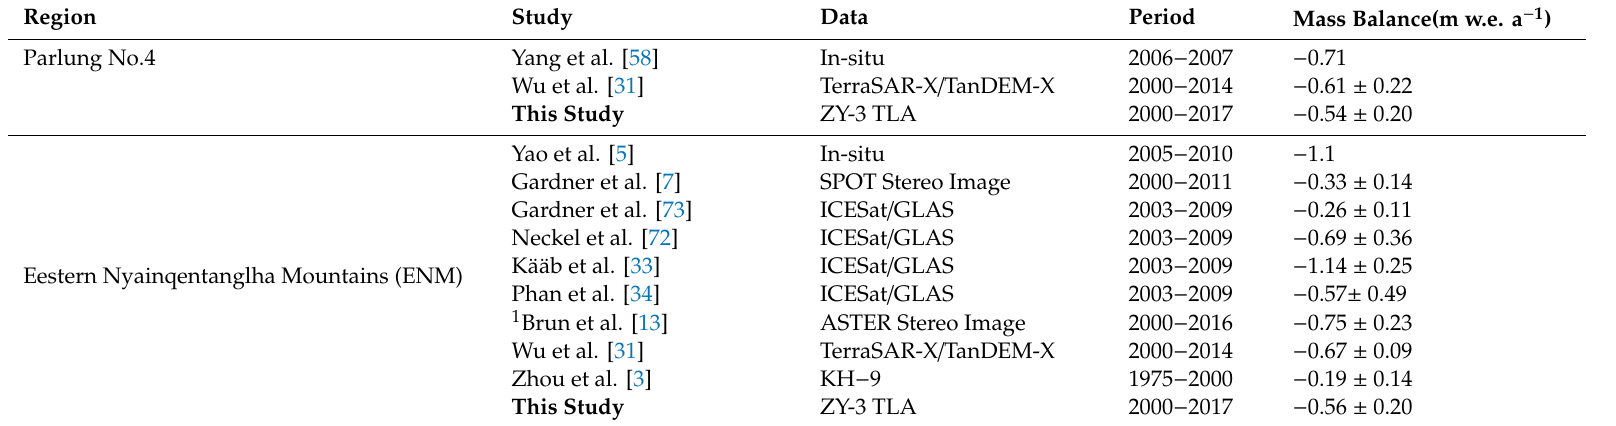
Table 9. Comparison of our geodetic glacier mass balance retrievals with previous with studies in the